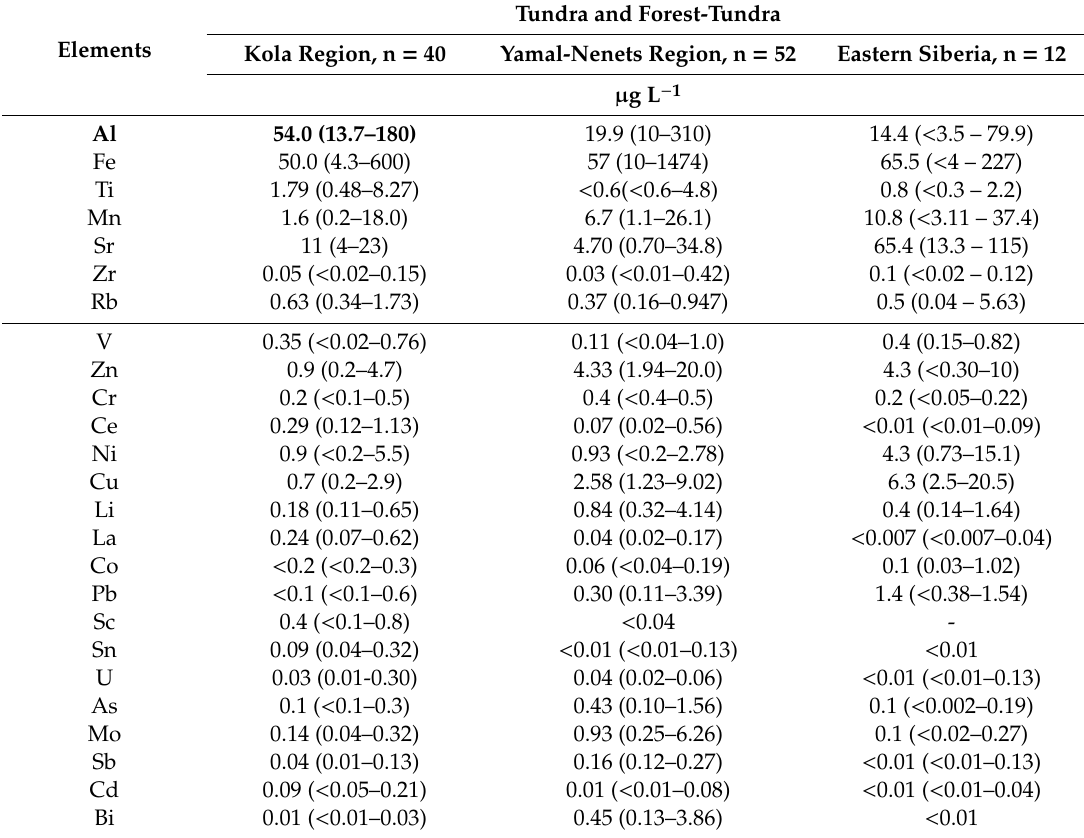
Table 2. Median and variability in trace element concentrations (min–max) in the water of lakes in the Arctic